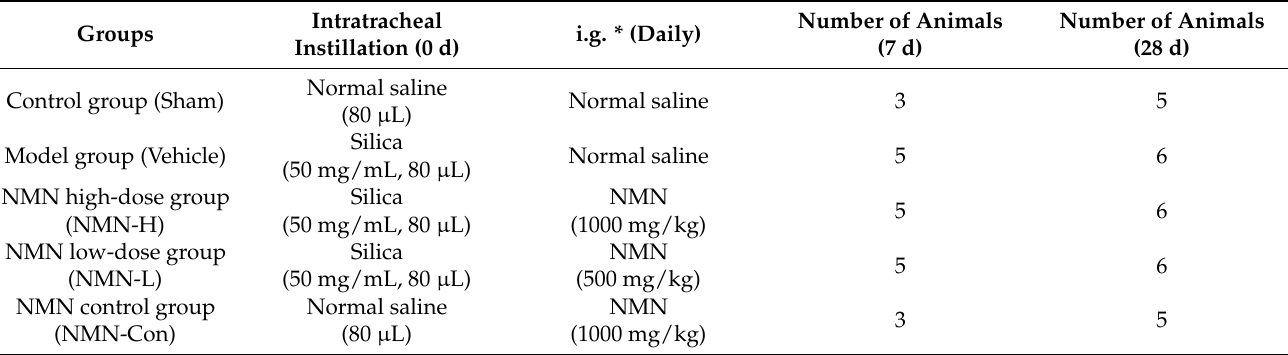
Table 1. Animal experiment design